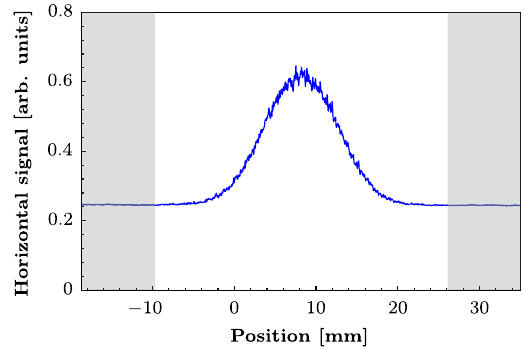
FIG. 20. Typical set of initial transverse profiles measured with the wire scanners. The offset of the baseline is clearly visible in both planes. The horizontal profile also exhibits a position offset due to the closed orbit distortion at the location of the wire scanner. Both offsets were removed prior to further treatment of the signals.